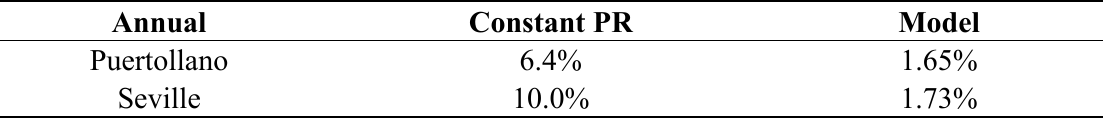
Table 11. Annual percentage differences between real and predicted annual EP for the two prediction